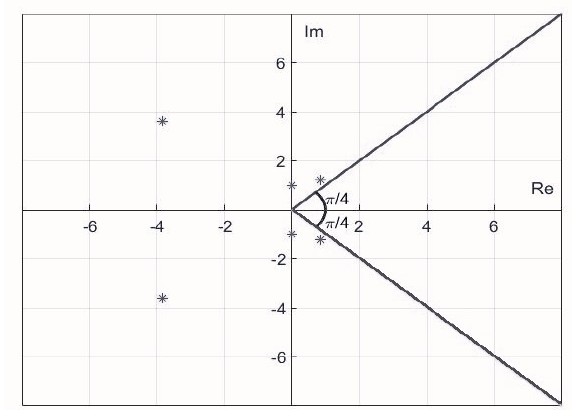
Figure 9. The roots of the PI controlled